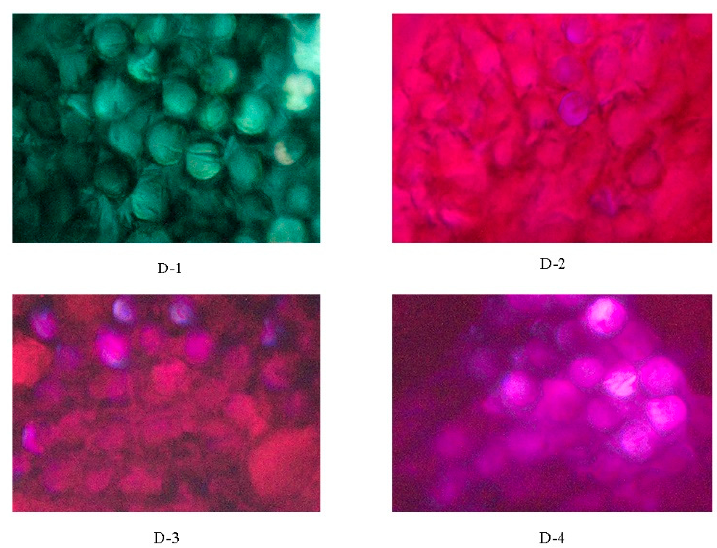
Figure 13. 3D microscope graph of wool/acrylic blended fabrics with heterocyclic dyes.